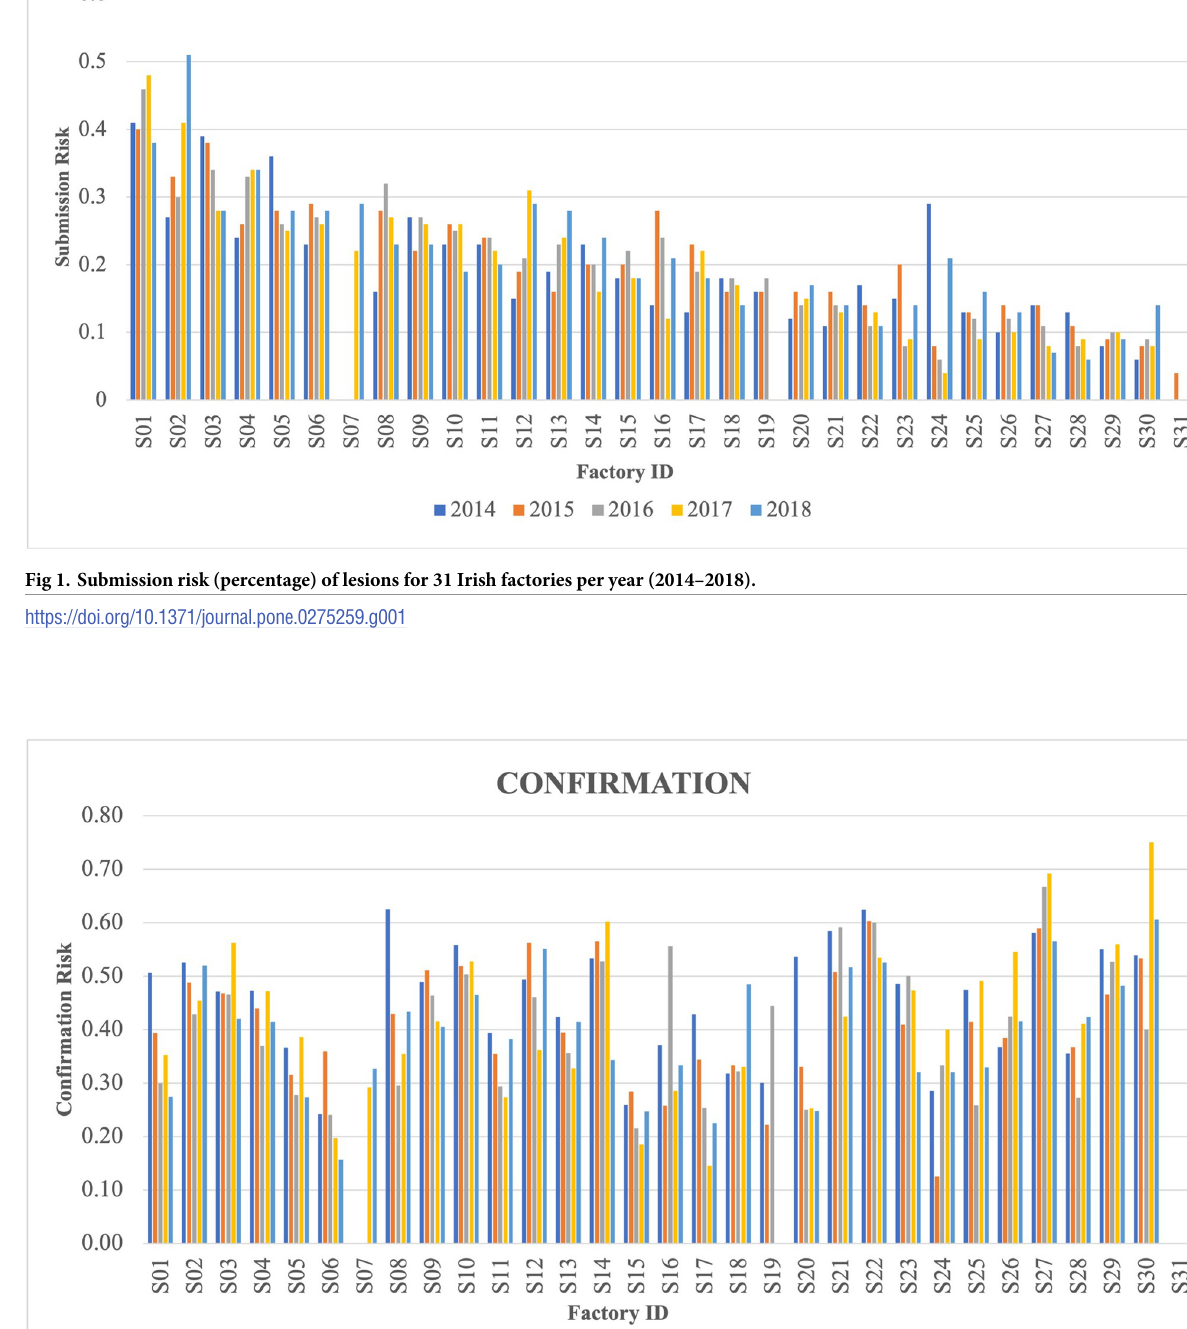
PLOS ONE | https://doi.org/10.1371/journal.pone.0275259 October 7, 2022 7 /